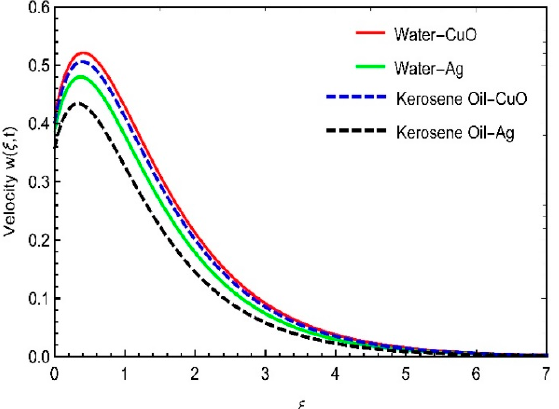
Figure 3. Comparative velocity profile for water- and kerosene-based nanofluids.